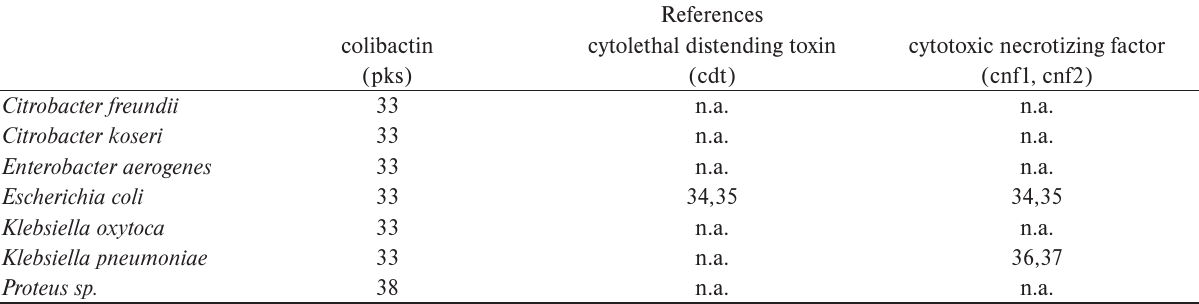
Table 2. Carcinogenic toxins present in enterobacterial intestinal